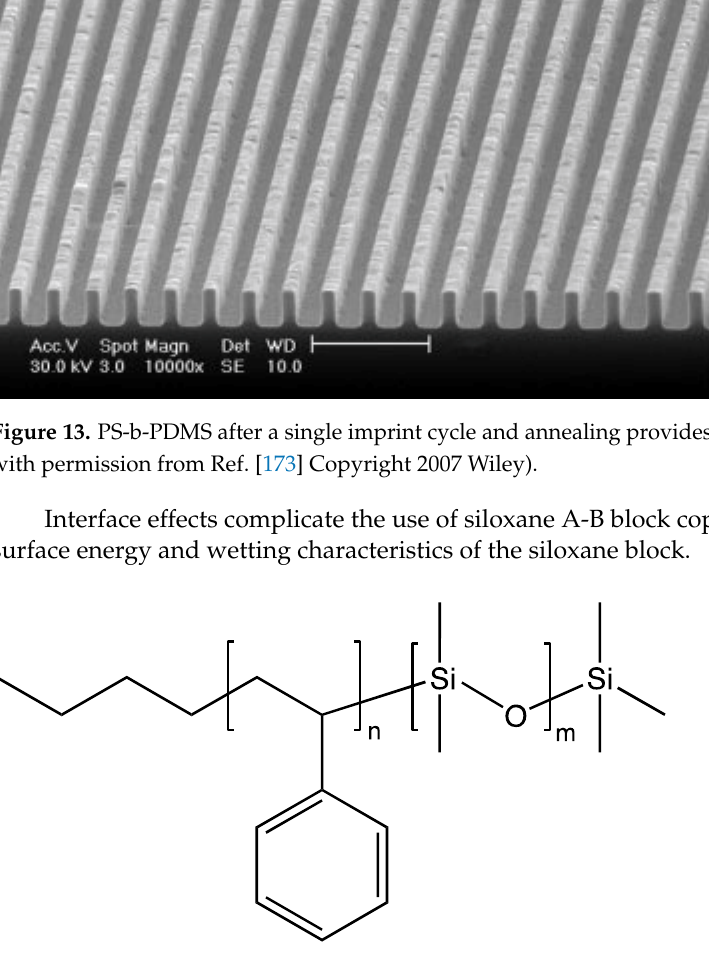
Scheme 15. Polystyrene-Polydimethylsiloxane Block